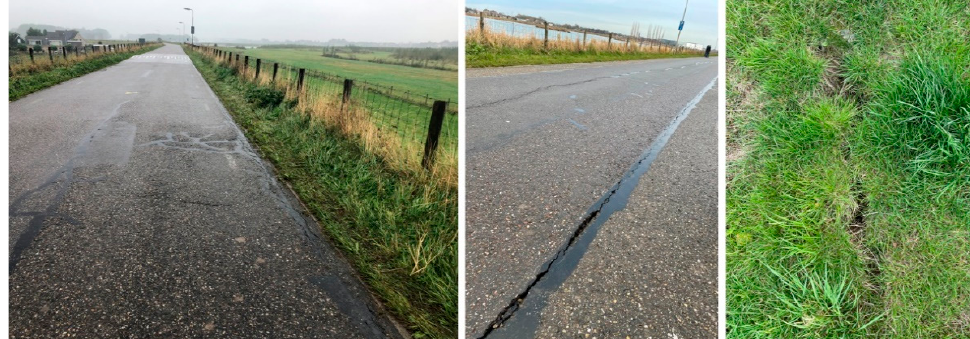
Figure 8. Presence of cracks on the embankment road and slopes.